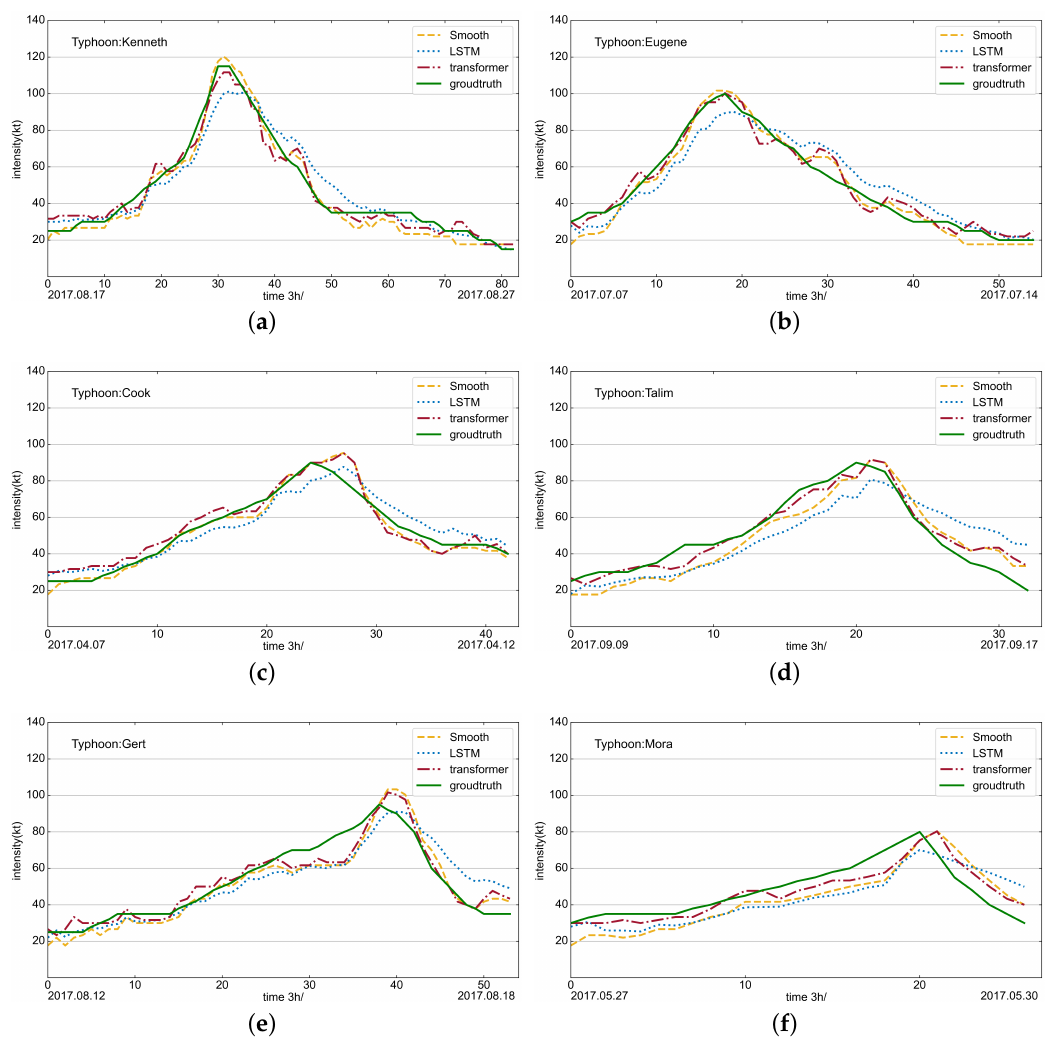
Figure 6. Every 3-hour intensity estimation results of three methods (Smooth, LSTM, and transformer). We selected six representative typhoons during 2017 from five regions (East Pacific, Southern Hemisphere, West Pacific, Atlantic, and Indian Ocean). From ( a – f ) are Kenneth from East Pacific, Eugene from East Pacific, Cook from Southern Hemisphere, Talim from West Pacific, Gert from Atlantic, and Mora from Indian Ocean